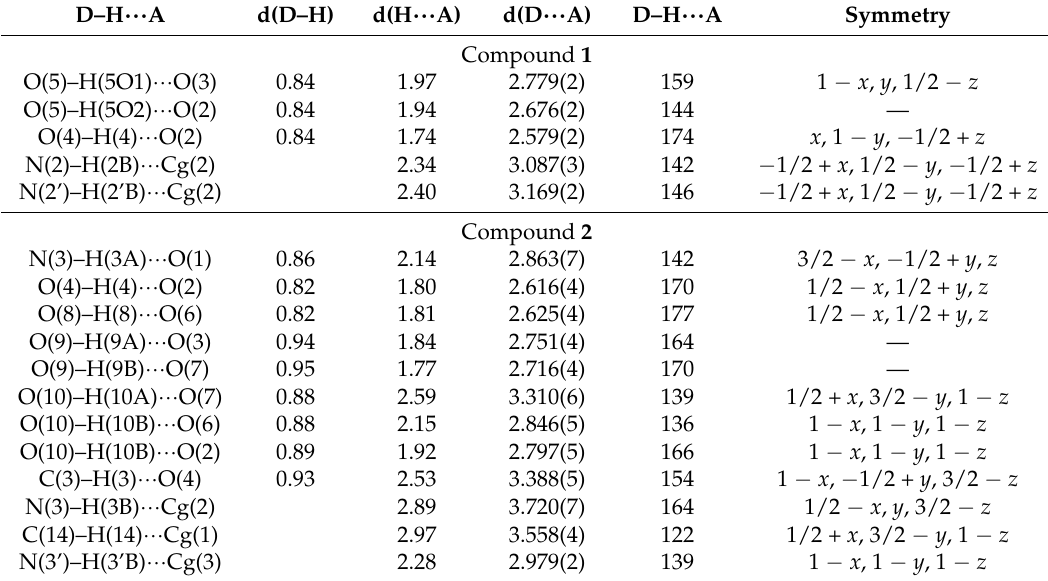
Table 2. Geometrical parameters of hydrogen bonds, N–H ··· π and C–H ··· π interaction for the title polymers (Å, ◦